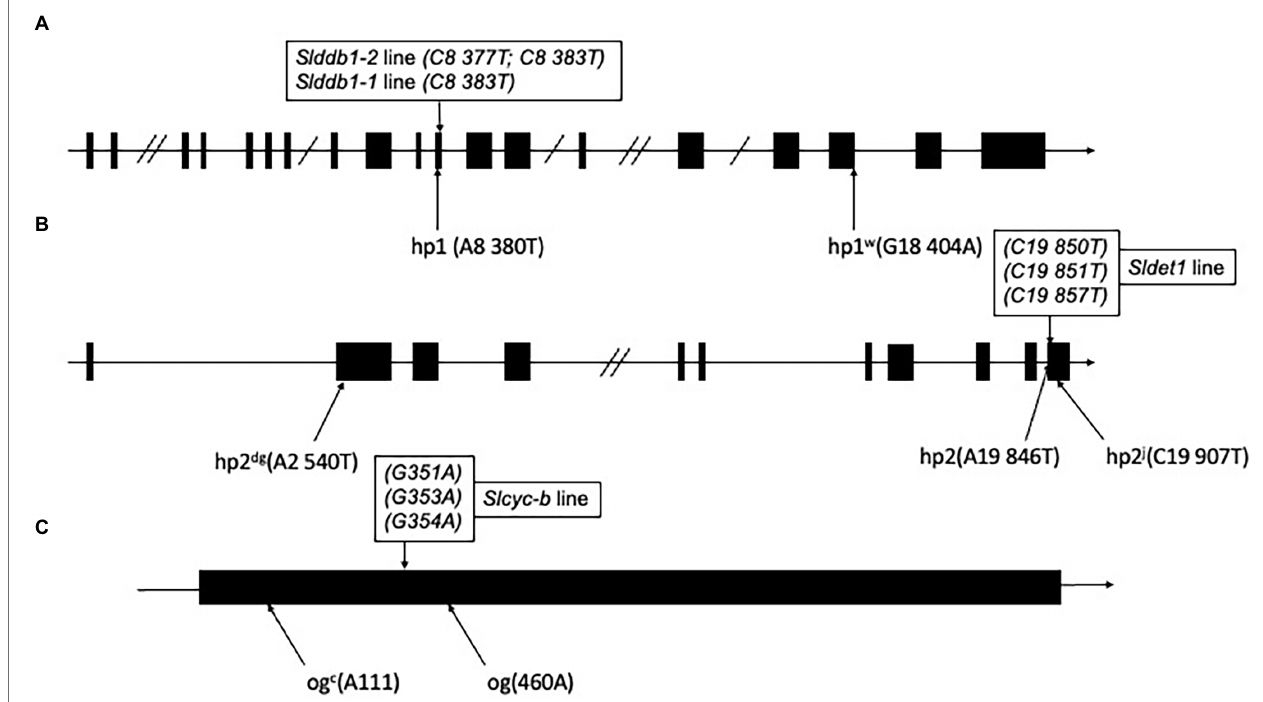
FIGURE 1 | Schematic representation of individual alleles generated in Slddb1, Sldet1 and Slcyc-b. (A) Slddb1, (B) Sldet1 and (C) Slcyc-b showing the previously described mutations and their corresponding annotations and positions compared to the first nucleotide of the start codon in the gene sequence. Black boxes represent exon regions, and lines represent introns or UTR regions. Double slashes in introns represent a reduction in the intron size. The box above each gene represents the mutated site by Target-AID with the corresponding nucleotide position in the gene relative to the start